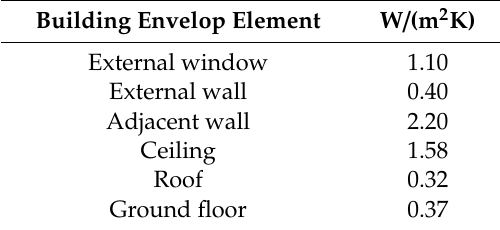
Figure 3. The mean hourly air temperature, horizontal solar radiation, and wind speed at ground level for Gdansk locality.